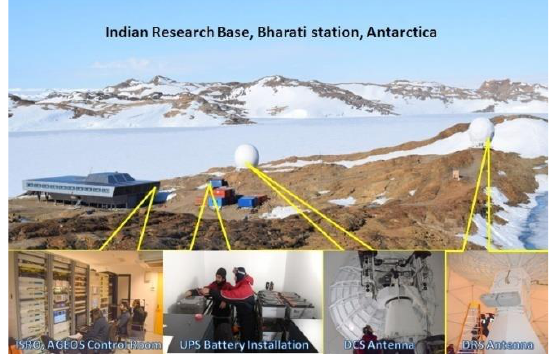
Figure 4. Systems at